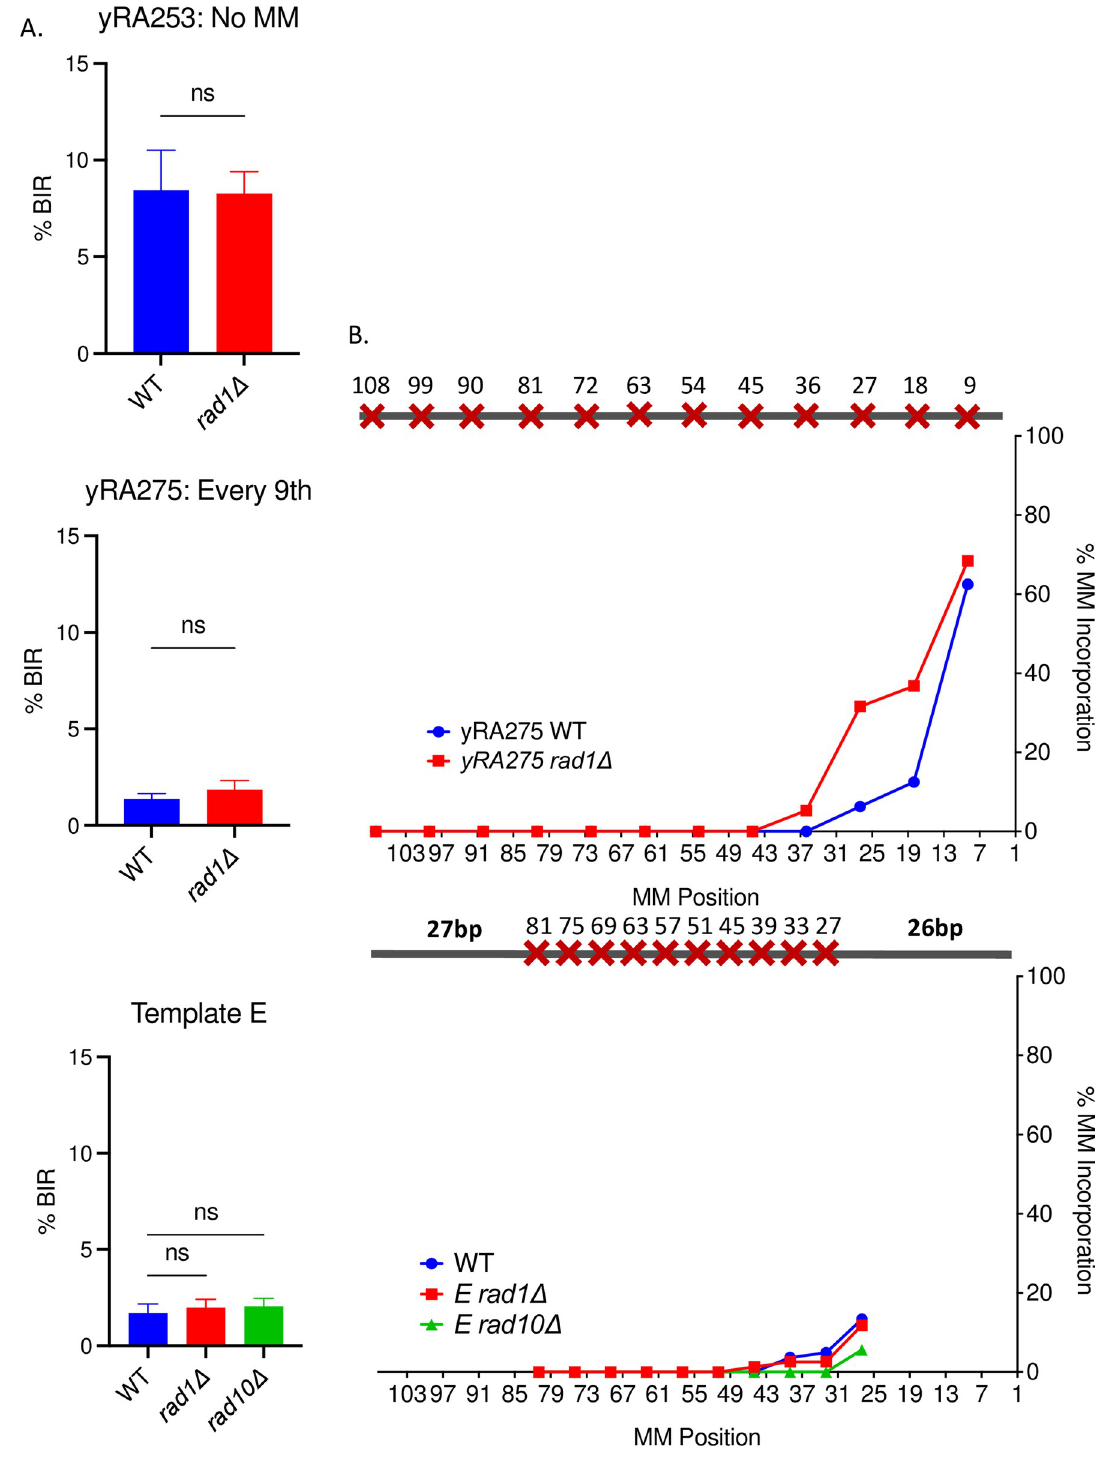
Fig 8. The mismatch assimilation of donor sequences does not depend on Rad1-Rad10 flap endonuclease. A. The effect of deleting the 3 0 -flap endonuclease RAD1 or RAD10 on BIR efficiency for yRA253 with mismatches every 9 th bp, and donor template E. Welch’s t- test was used to determine the p-value. Error bars refer to standard error of the mean. A minimum of at least five measurements were performed. B. The effect of deleting the 3 0 -flap endonuclease Rad1 or Rad10 on mismatch incorporation pattern for yRA253 (WT) with mismatches every 9 th bp and donor template E. For all % mismatch incorporation data, a minimum of 40 samples were DNA sequenced.